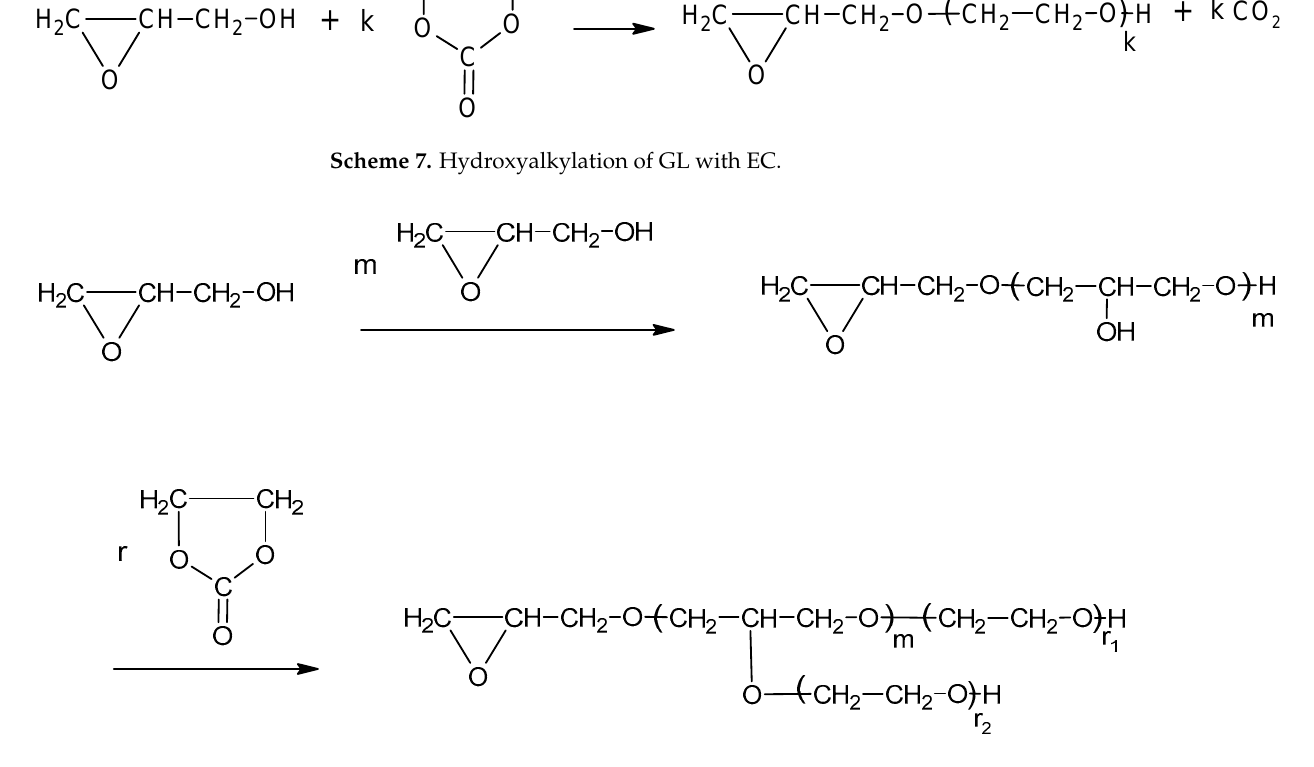
Scheme 8. Oligomerization of GL and hydroxyalkylation of oligomers with EC.